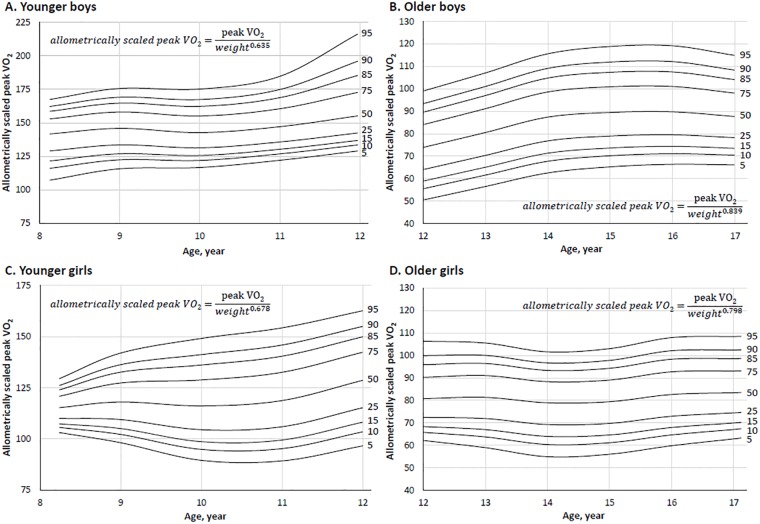
Percentile curves of allometric scaled peak VO2 in age- and sex-specific subgroups.